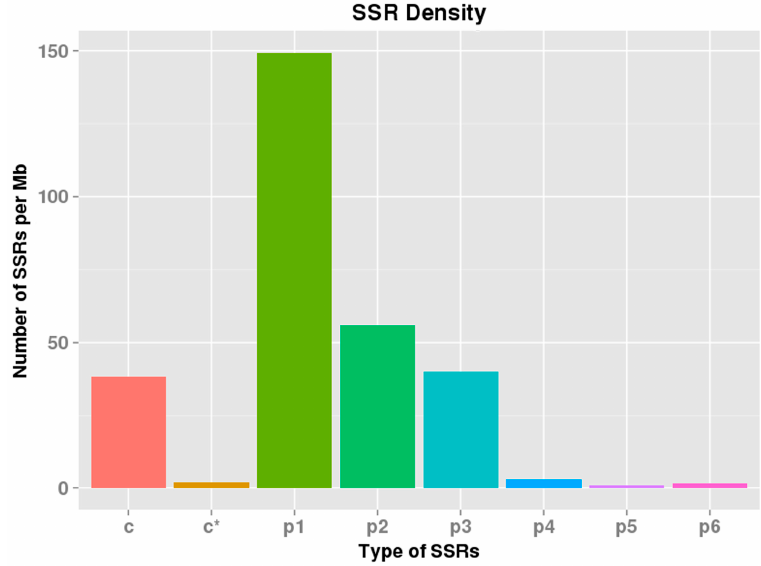
Figure 6. SSR density distribution.